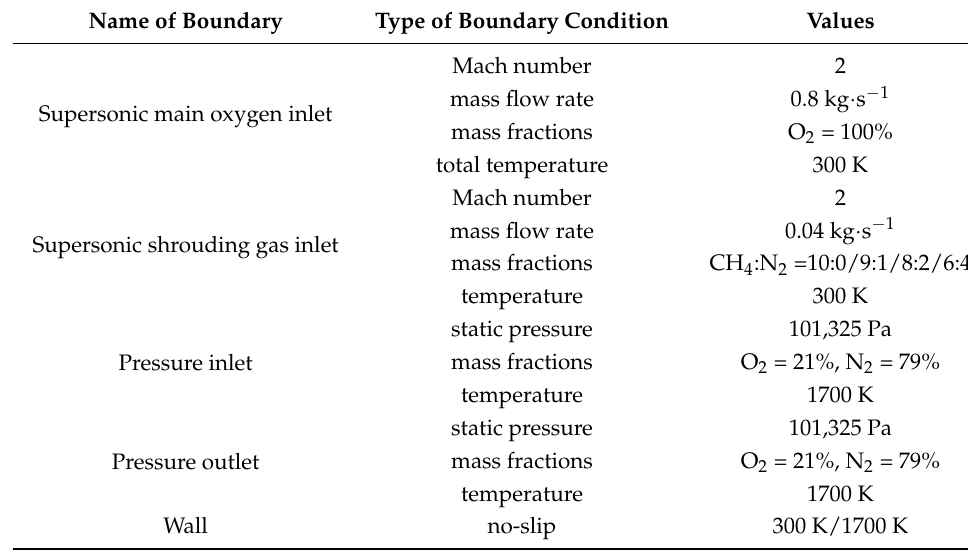
Figure 3. Calculation model and boundary conditions. Table 1. Parameters of boundary condition.